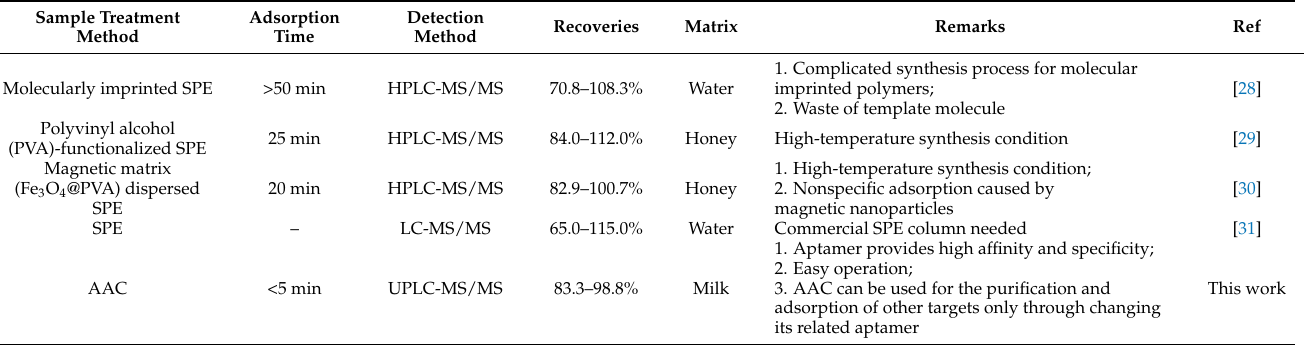
Table 6. Comparison with other